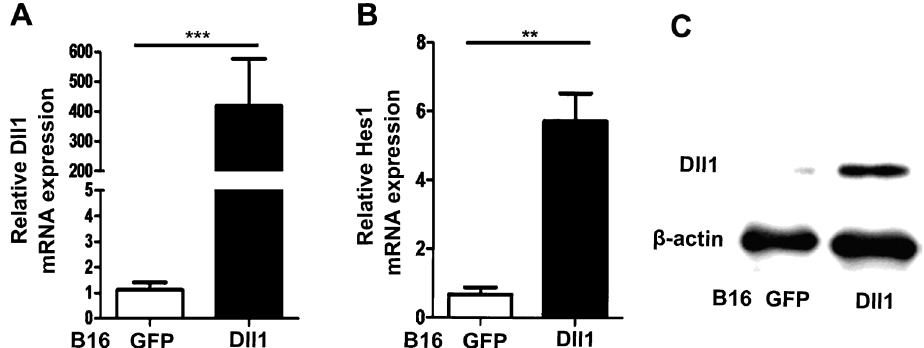
Figure 1. Overexpression of Dll1 activated Notch signaling in B16 cells. A , Quantitative PCR revealed expression of Dll1 mRNA in transfected cells. B , Expression of Notch down-stream gene Hes1 was observed in transfected B16 tumor cells. C , Dll1 protein was detected by Western blot in B16 tumor cells. Data are reported as means±SD. **P , 0.01, ***P , 0.001, unpaired Student t -test,